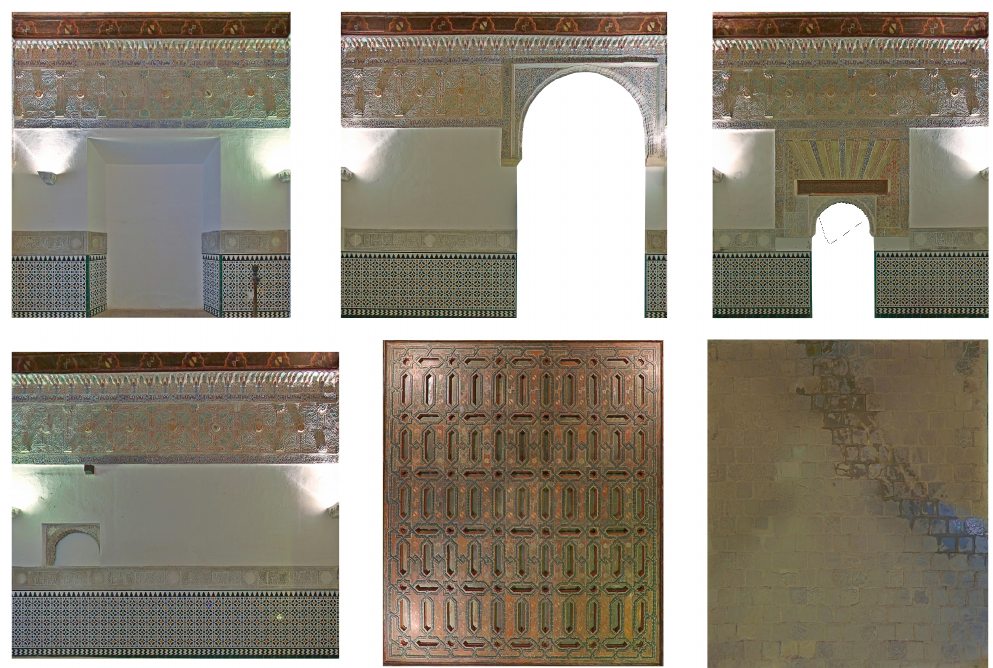
Figure 4. The six metrically rectified images generated for the planar